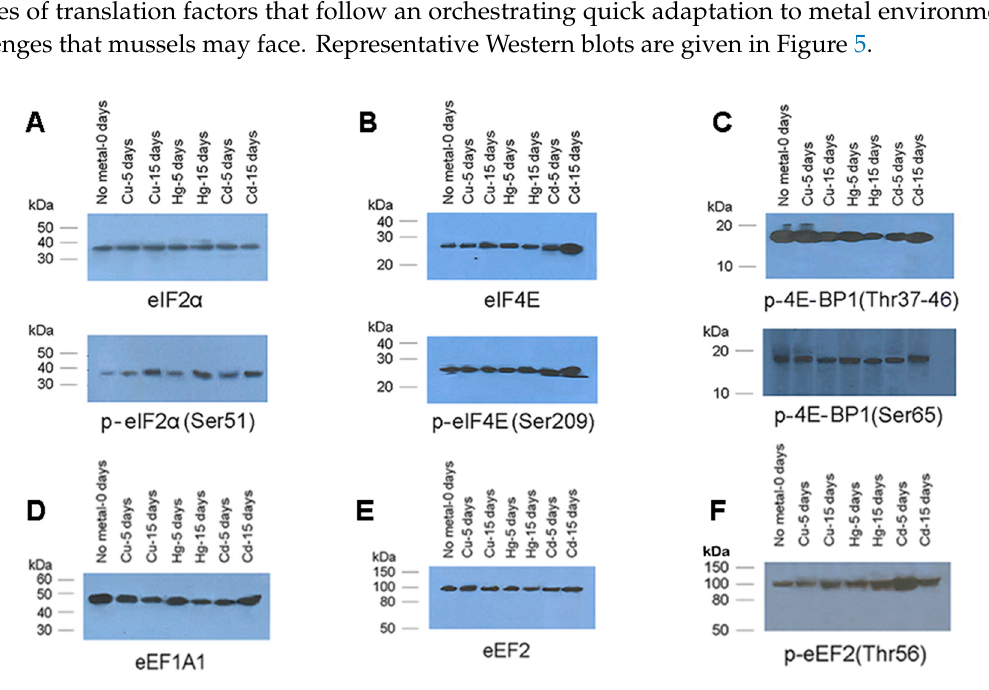
Figure 5. Western blots demonstrating translation factors’ abundance. ( A ) eIF2 α and p-eIF2 α (Serine51), ( B ) eIF4E and p-eIF4E (Serine209), ( C ) p-4E-BP1 (Threonine37 / 46) and p-4E-BP1 (Serine65), ( D ) eEF1A1, ( E ) eEF2, ( F ) p-eEF2(Thr56)of exposed mussels to 40 µ g / L Cu, 30 µ g / L Hg, or 100 µ g / L Cd for 5 or 15 days (pstands for the phosphorylated translation factor, and the aminoacid mentioned in parentheses indicates the site of